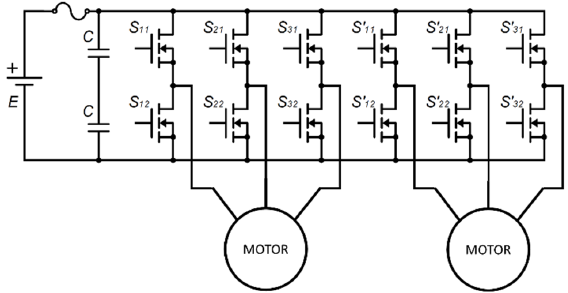
Figure 13. Conventional inverter topology for a dual motor system.